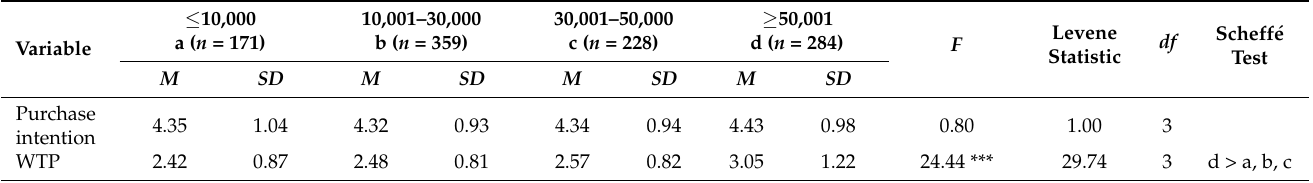
Table 7. One-way ANOVA for monthly disposable income level ( n =